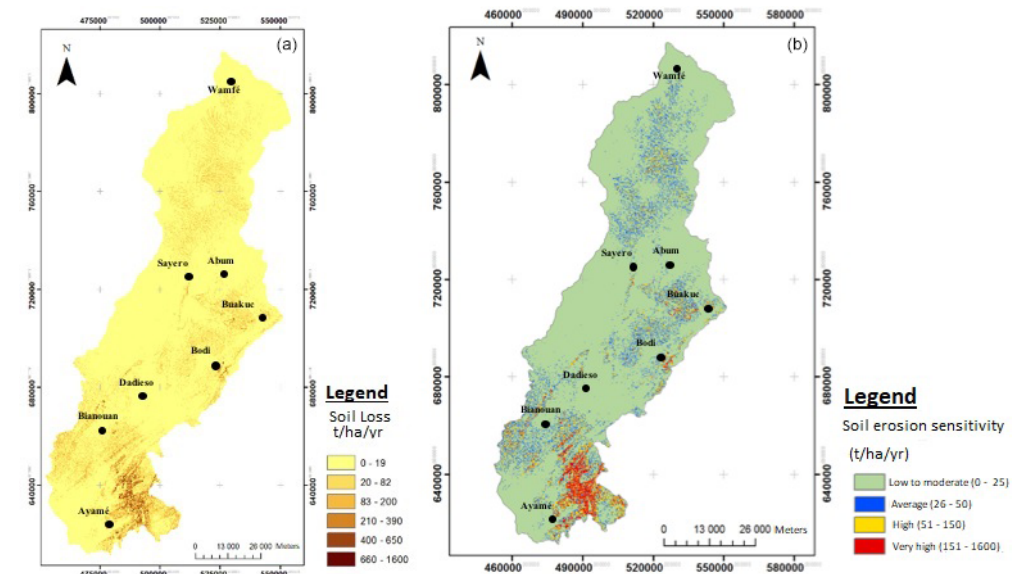
Figure 4. The different erosion factors of the Bia catchment area: (a) Soil loss – (b) Soil erosion